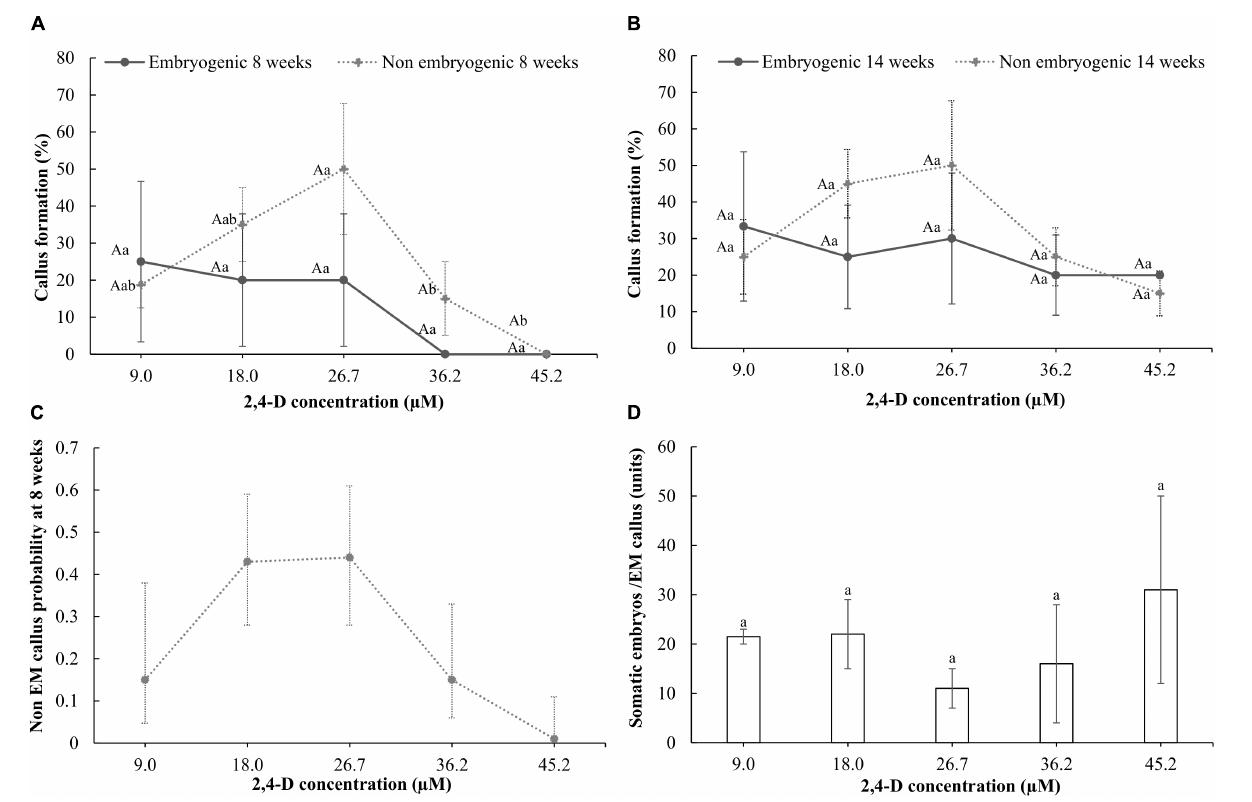
FIGURE 1 | Response of half-cut seeds to different concentrations of 2,4-D (9.0, 18.0, 27.1, 36.2, or 45.2 µ M) after 8 (A) and 14 weeks of culture (B) . Probability of formation of callus with embryogenic structures in half-cut papaya seeds cultured for 8 weeks (C) ; Wald t -test: X 2 = 8.8, p ( > X 2 ) = 0.0031. Estimated probability equation: P ( y ) = 1 /( 1 + e ( 4 . 136 − 0 . 4 x + 0 . 00921 x 2 ) ) ; p- value = 9.744555e − 06 ; and the quantity of somatic embryos formed per each embryogenic (EM) callus after 14 weeks of culture (D) . Vertical bars correspond to the standard deviation of the means (A,B,D) or of the calculated probabilities (C) . Uppercase letters denote significant differences between weeks of culture for the same treatment and type of callus. Lowercase letters denote significant differences between treatments for each week of evaluation and type of